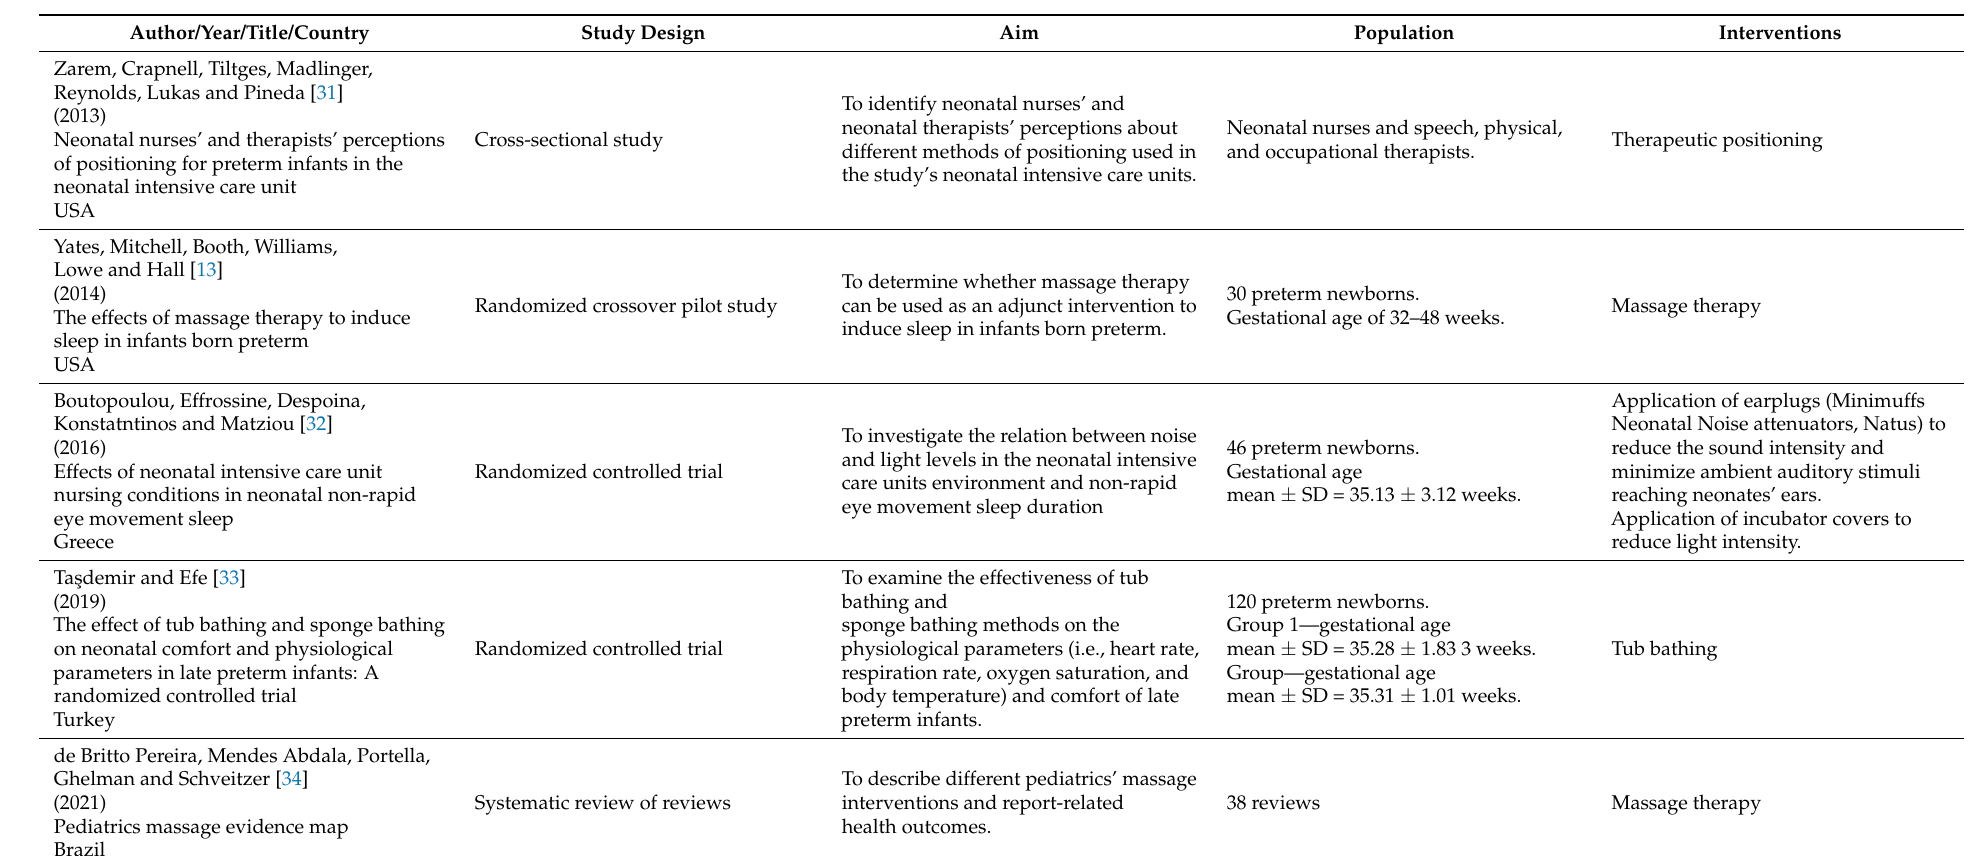
Table 1. Data extraction and